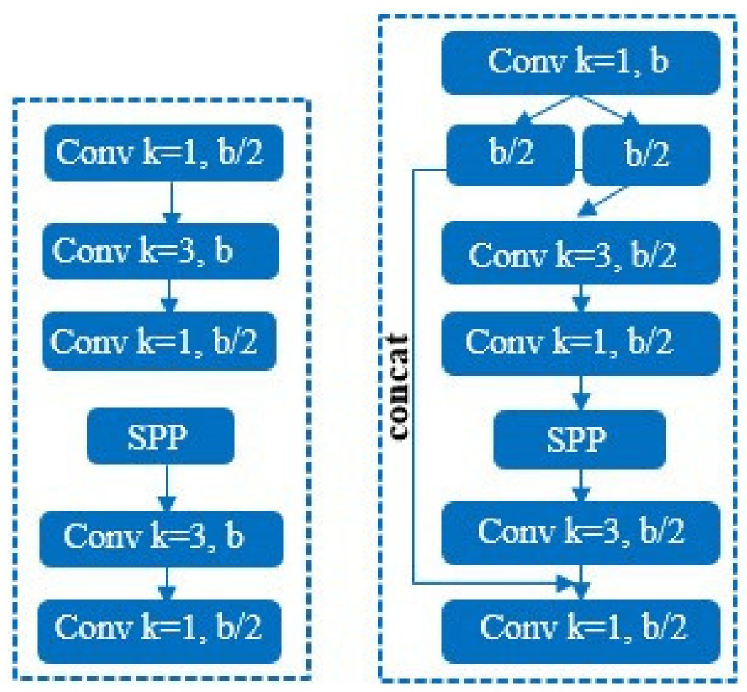
Figure 2. Computational blocks of SPP and